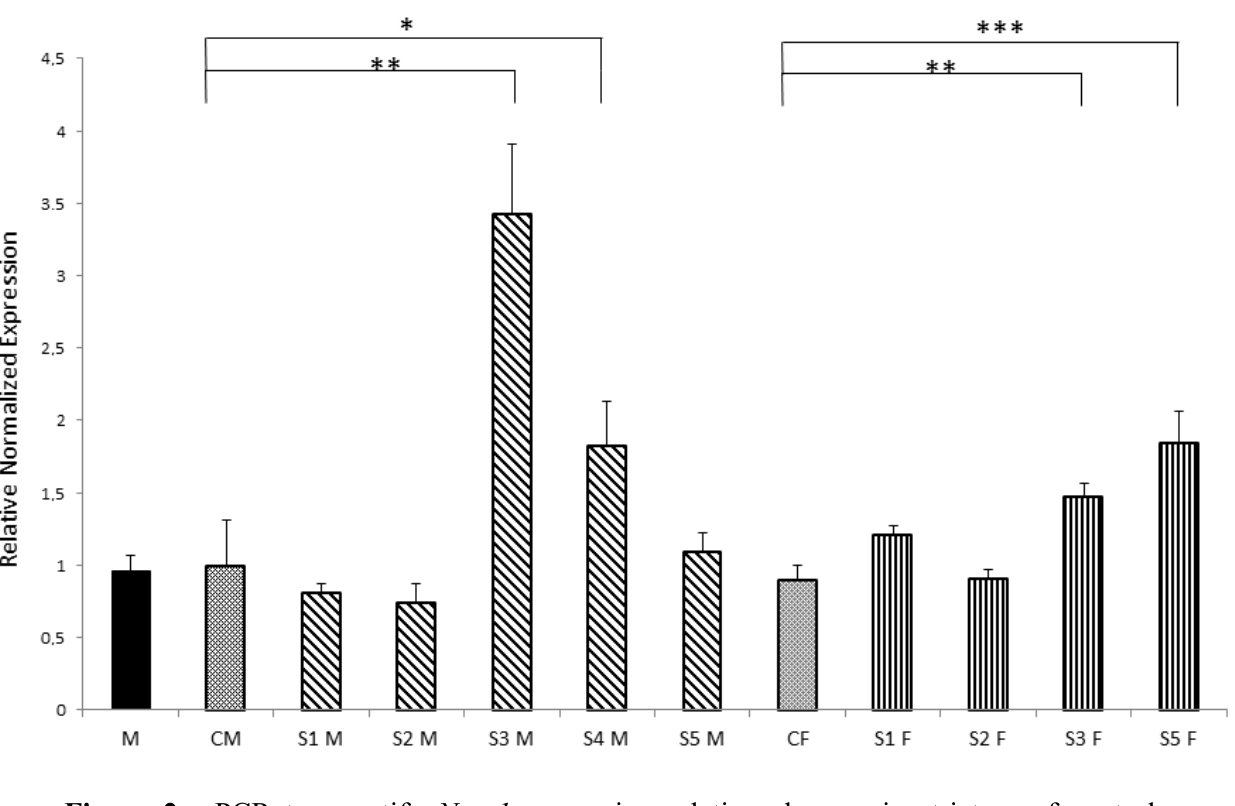
Figure 2. qPCR to quantify Nurr1 expression relative changes in striatum of control, early life treated mother and offspring (F1 generation, untreated rats). All expression values were normalized to the value of β-actin gene used as an internal control. * p < 0.05; ** p < 0.01; *** p < 0.001 vs. matched sex control